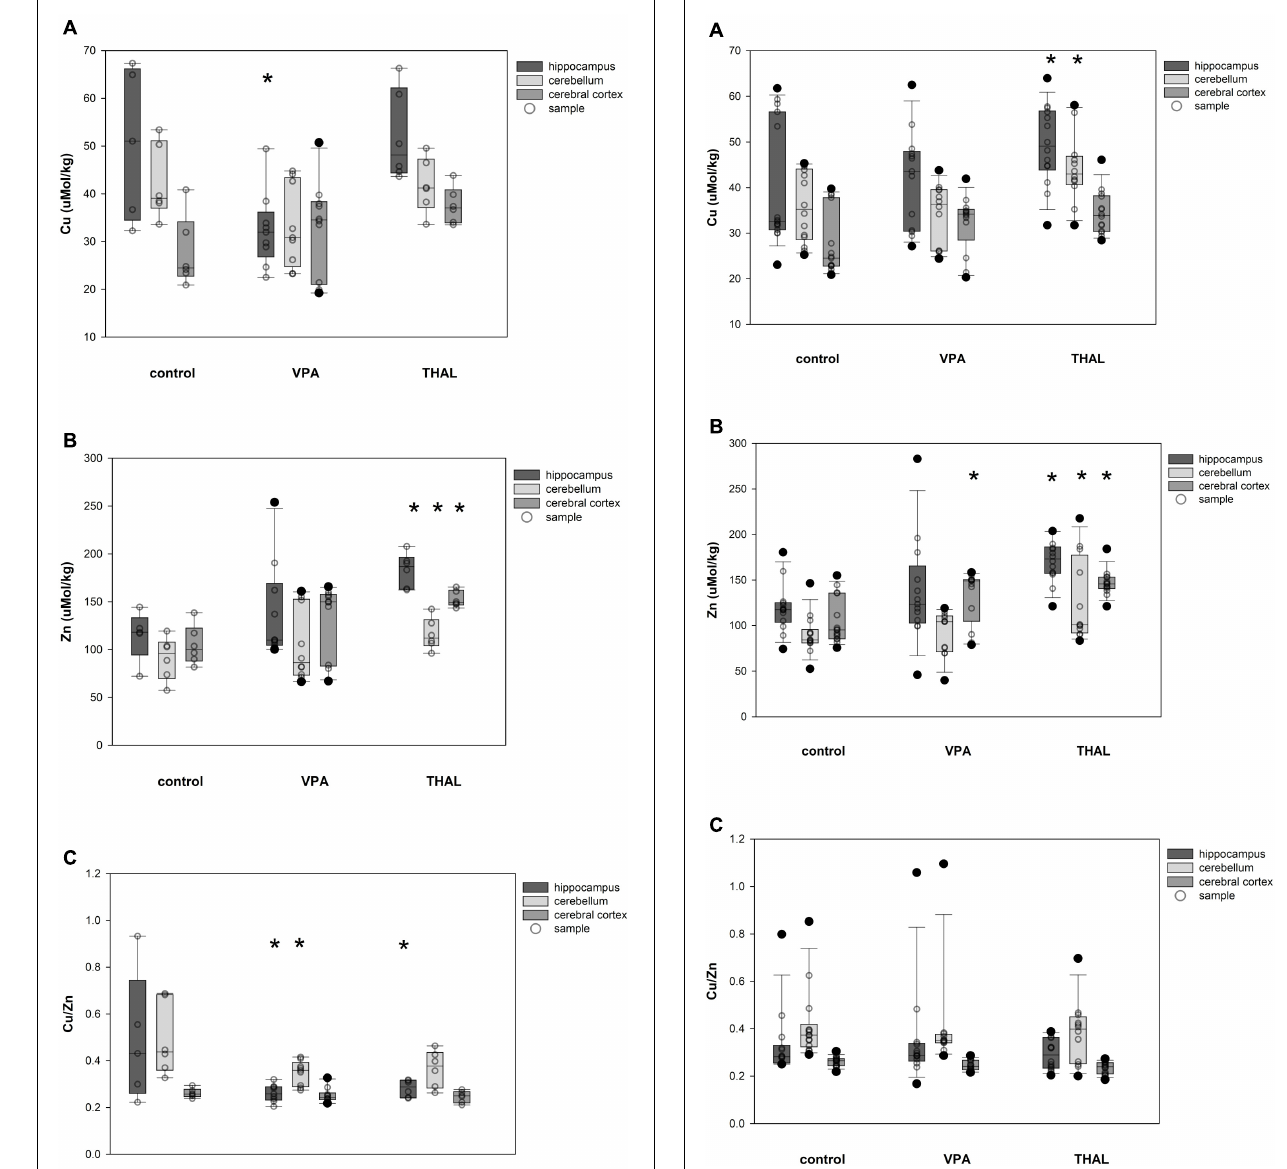
beta adrenergic Adrb3 as well as of the Adrbk1 gene encoding the G protein-coupled receptor kinase 2/beta-adrenergic receptor kinase 1, also involved in regulation of adrenergic signaling.